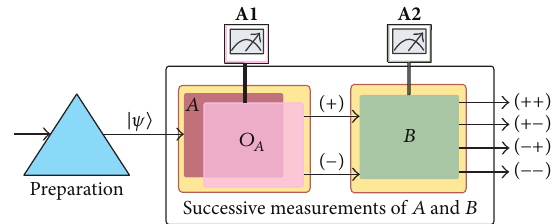
Figure 1: A successive measurement scheme of observables 𝐴 and 𝐵 exploitedforthedemonstrationoftheerror-disturbanceuncertainty relation. After state preparation (blue) apparatus A1 carries out a projective measurement of 𝑂 𝐴 instead of 𝐴 (light red), thereby disturbing observable 𝐵 which is detected by apparatus A2 (green), error 𝜖(𝐴) anddisturbance 𝜂(𝐵) arequantitativelydeterminedbythe four possible outcomes denoted by ( ++ ), ( +− ), ( −+ ), and ( −−